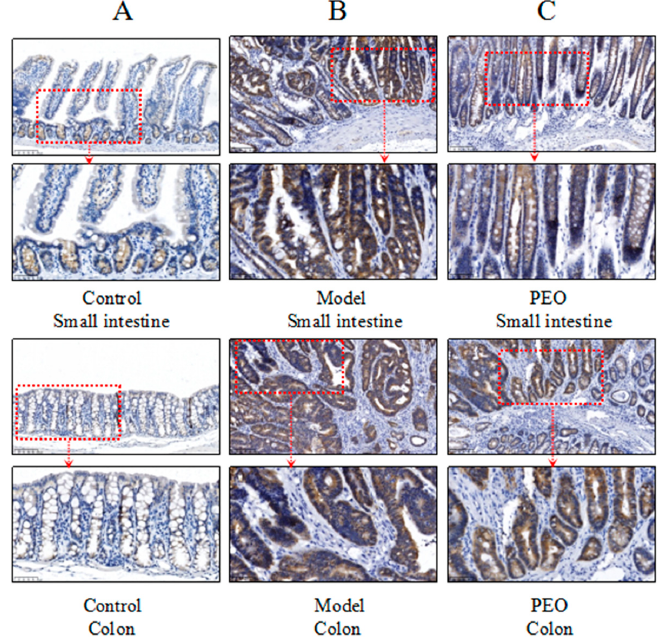
Figure 4. The expression of β -catenin in control group ( A ); model group ( B ); PEO (0.2% diet) group ( C ) was analyzed by immunohistochemistry, bar = 100 μ m (20 μ m × 5) and bar = 50 μ m (10 μ m × 5). Samples were scanned by Nano Zoomer 2.0 HT and pictures were obtained from NDP. View 2 (Hamamatsu Photonics K.K., Hamamatsu, Japan).